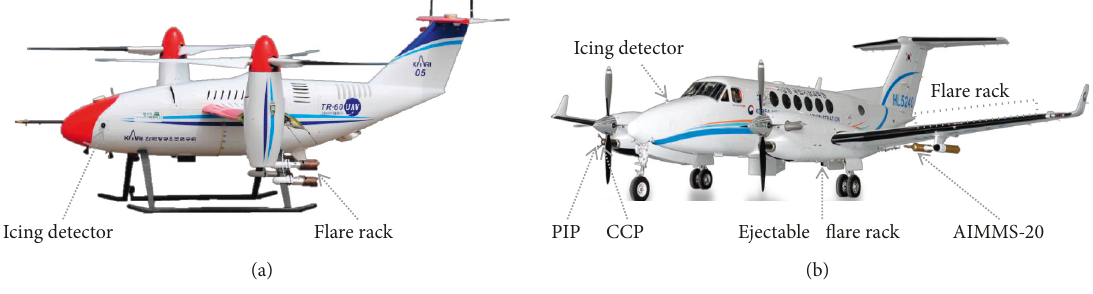
Figure 1: Aircraft and its instruments in (a) UAV and (b) NARA. Table 1: Specification of UAV and